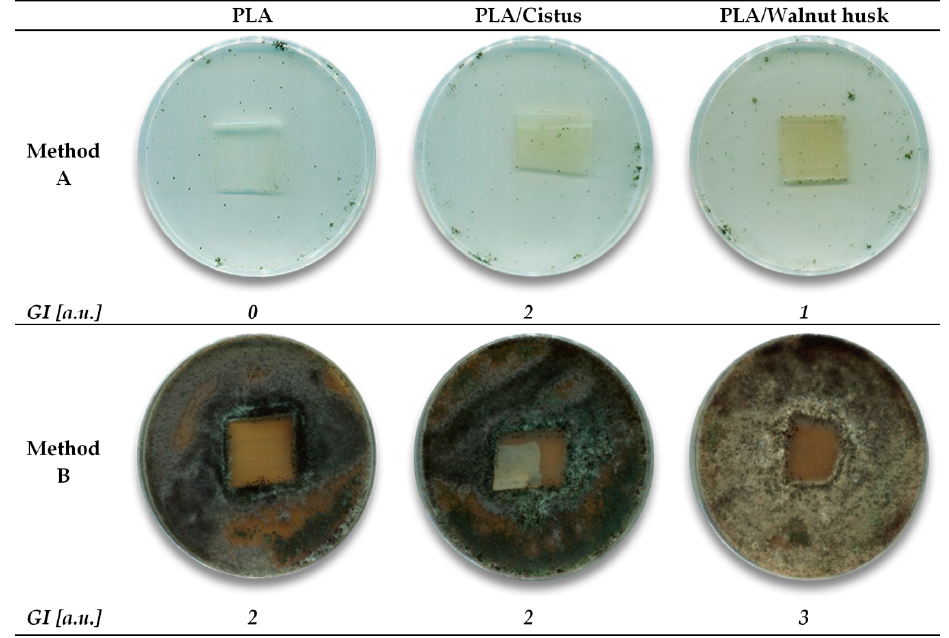
Table 3. Differential scanning calorimetry (DSC) analysis of PLA samples impregnated with extracts of Cistus and walnut